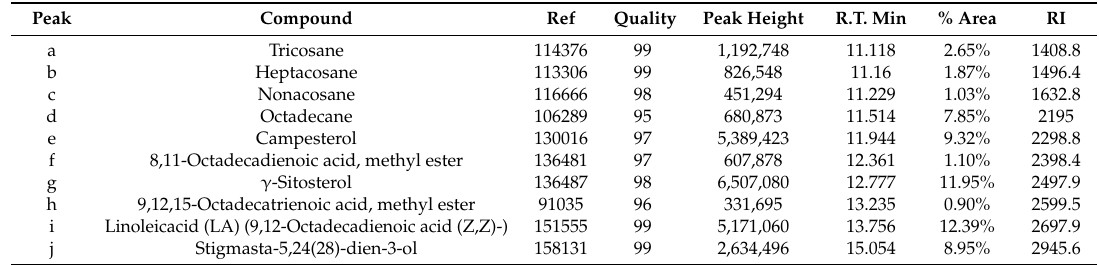
Table 2. GC-MS screening of the phytochemicals present in the R. coriaria ethanol extract. Peak